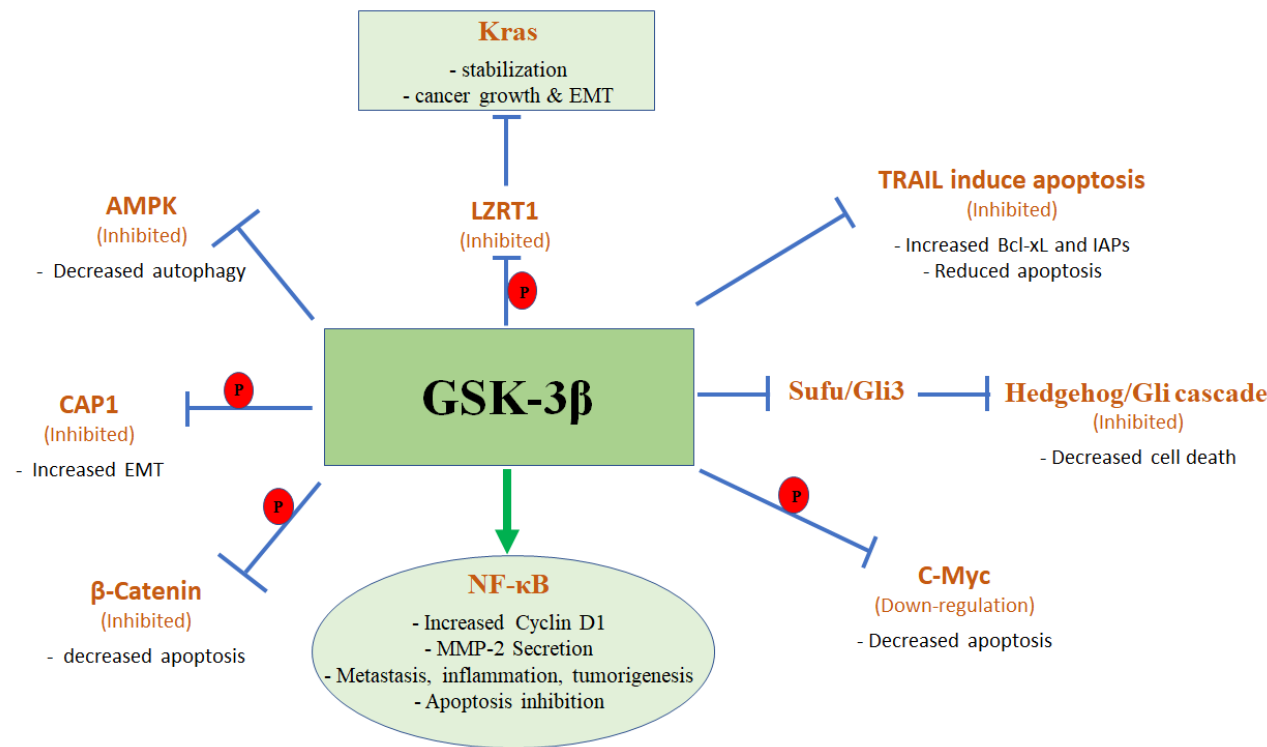
Figure 3. Oncogenic pathways up-regulated by GSK- 3β.